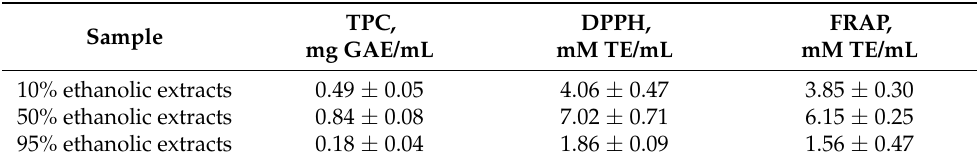
Table 1. Total phenolic content (mg GAE/mL) and in vitro antioxidant activities (mM TE/mL) in extracts.